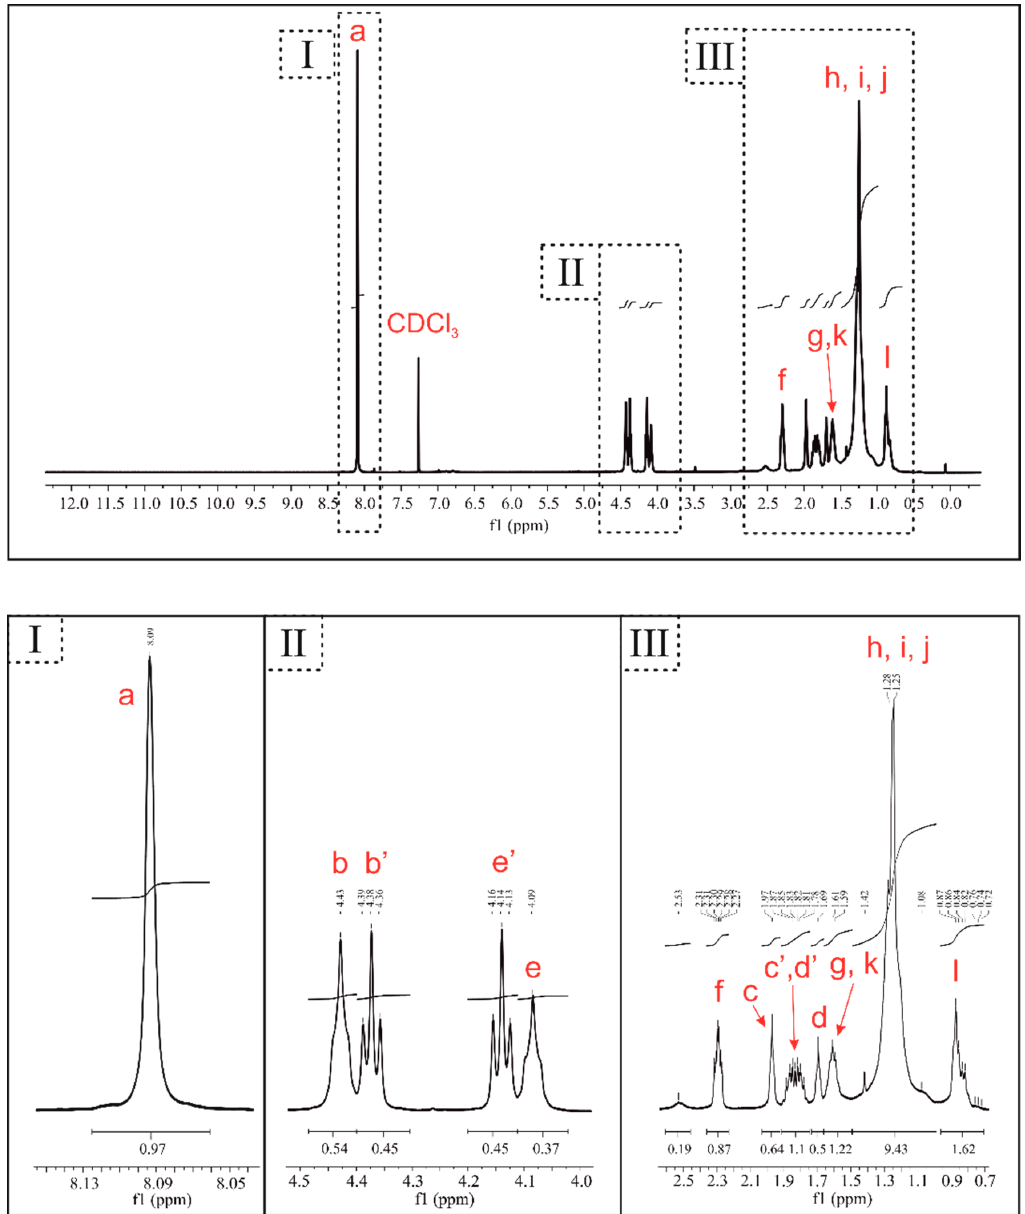
Figure 2. 1 H NMR spectra of PBT–DLA copolymer.